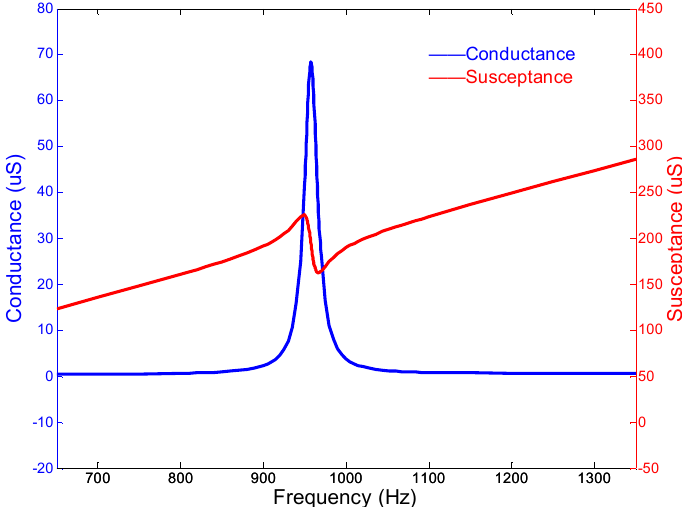
Figure 5. Admittance curves of the cascade-connected transducer with twelve segments.